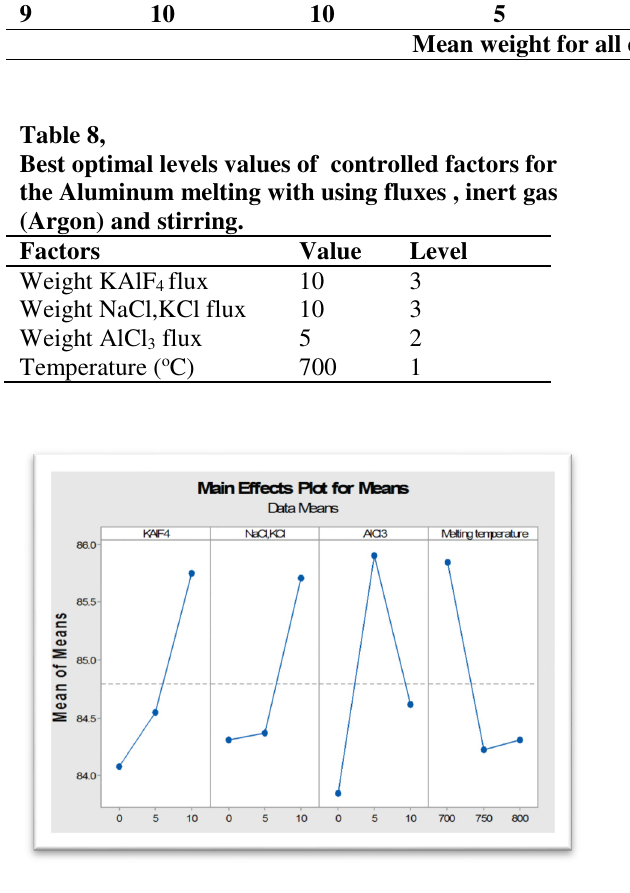
Fig. 2. Melting efficiency of Aluminum by using defferent types of fluxes and different temperatures for each level of the controlled